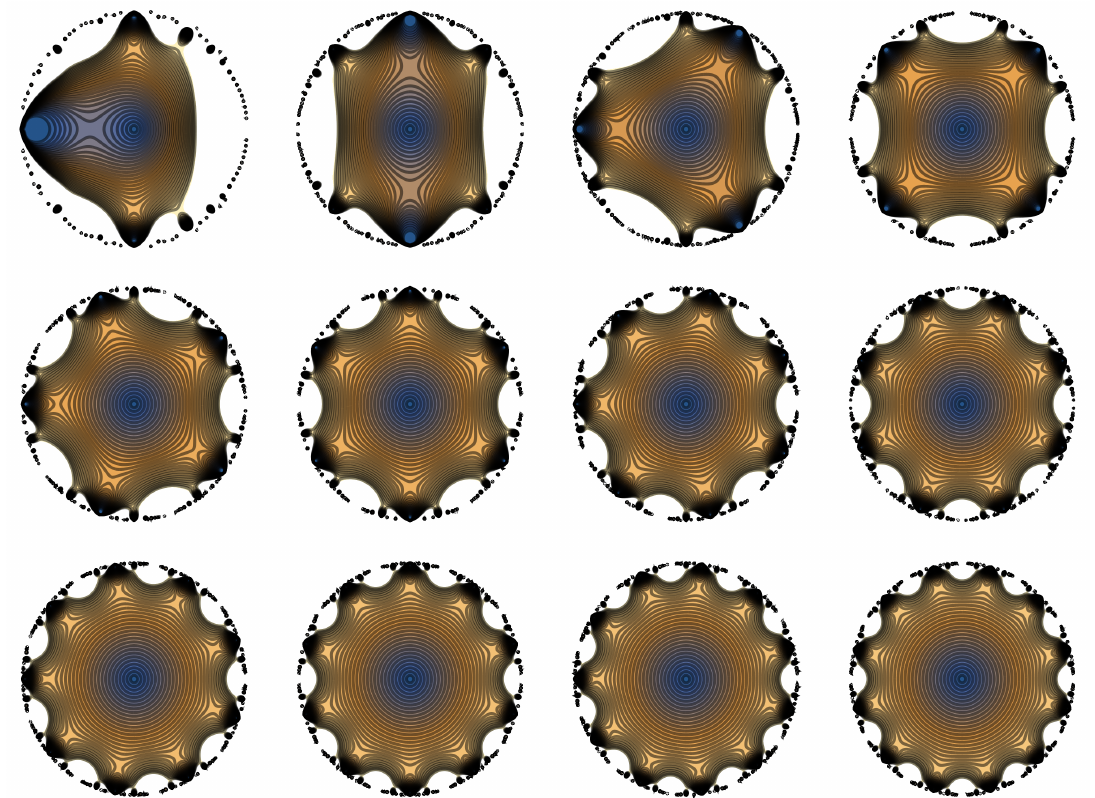
Figure 2. Contour plot of | L ( C ( k ) ; z ) | for k = 1 to k = 12 and N = 16. The 30 contours (level sets) in each graph are plotted from 0 to 1. Blue shading represent low values and orange shading represents high values. The rotational symmetry (equal to k ) of the graphs are visually apparent. Further, the contours are not rough (referred to here as “polished”). Both of these features are special to centered polygonal lacunary